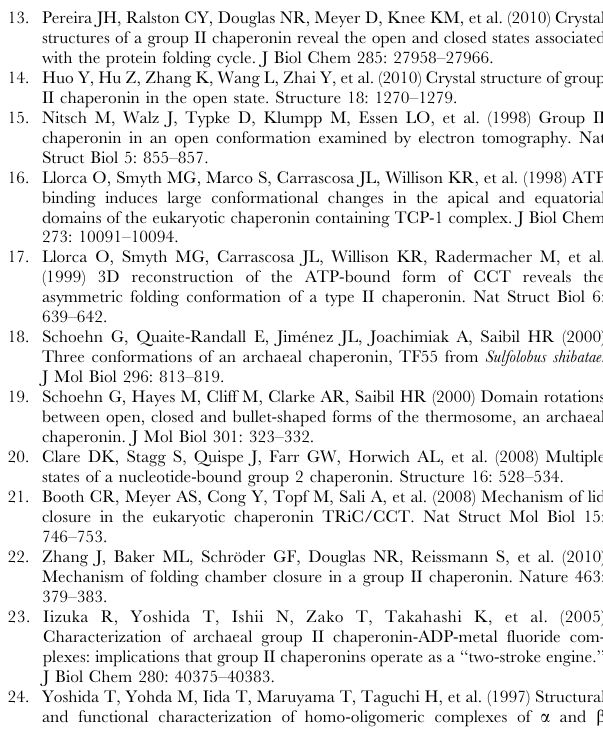
Figure S3 Distributions of time before photobleaching of a single BSR molecule. The surface-immobilized BSR-CPN was observed by epifluorescence microscopy at 23 u C and 50 u C. The distributions of time before photobleaching of single BSR molecules at 23 u C ( A ) and 50 u C ( B ) were fitted with a single exponential function ( solid lines ), which yields the rate constants of 0.052 s 2 1 and 0.051 s 2 1 ,